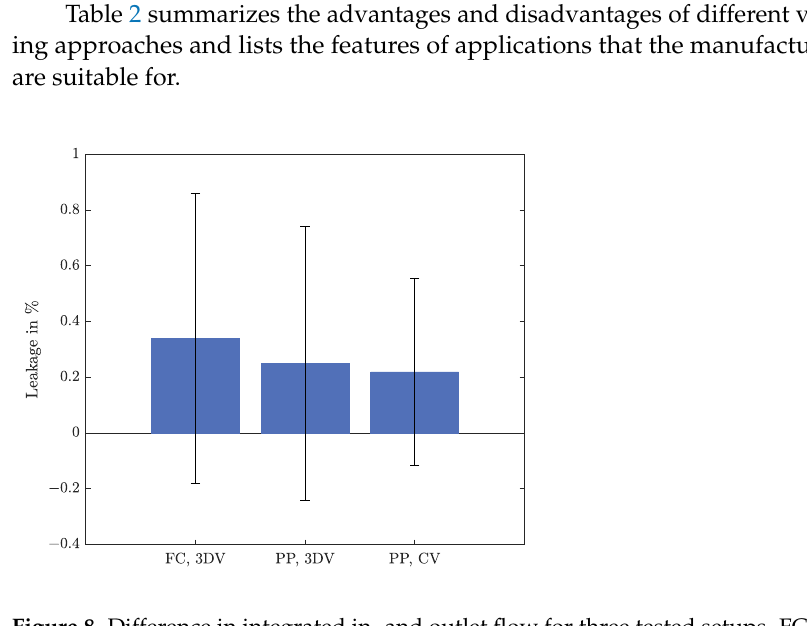
Figure 8. Difference in integrated in- and outlet flow for three tested setups. FC: microfluidic flow controller; 3DV: 3D-printed valve; PP: piston pump; CV: column valve of Äkta